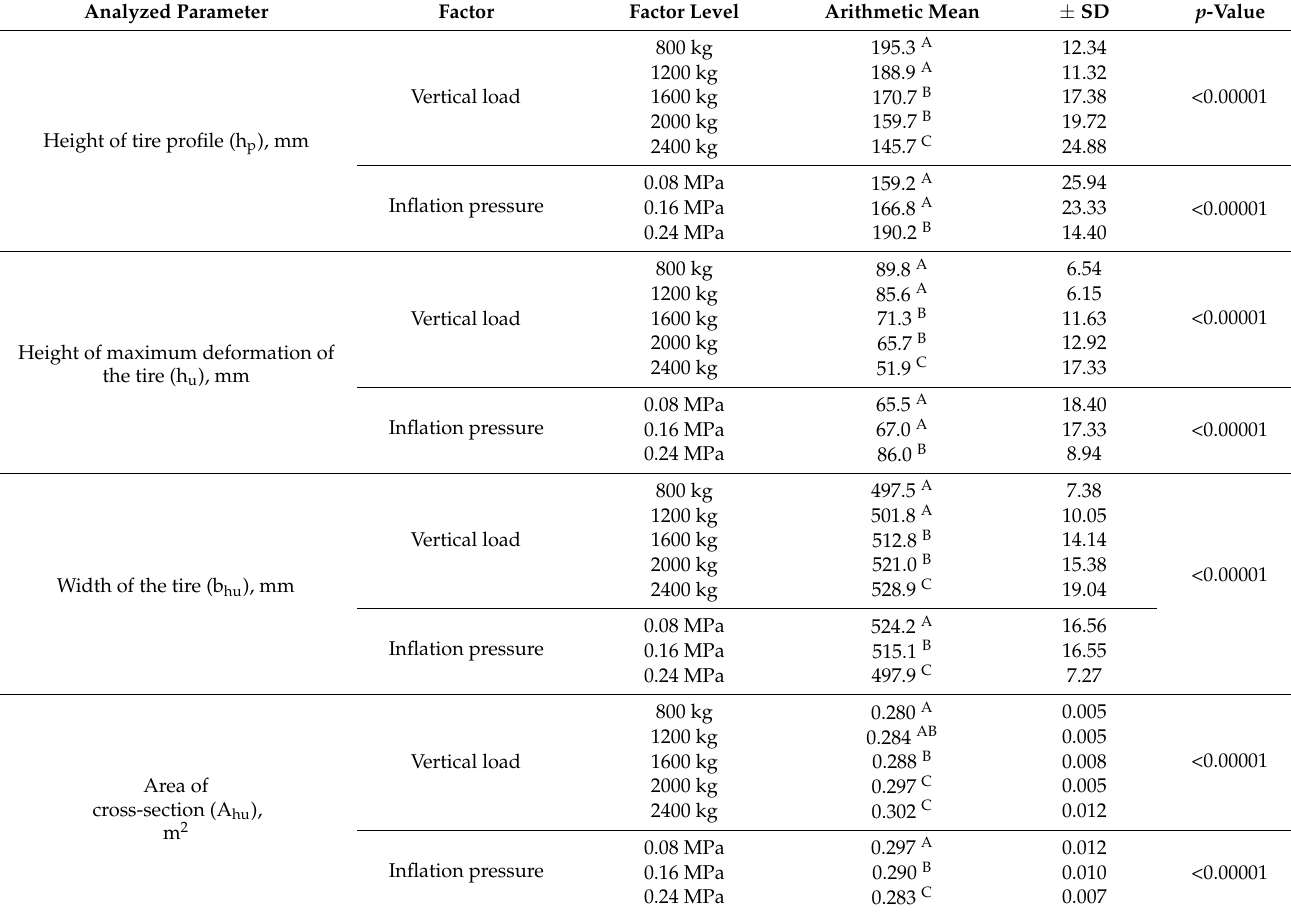
Table 3. Results of statistical analysis for bias-ply tire, the significance level α = 0.05, SD—standard